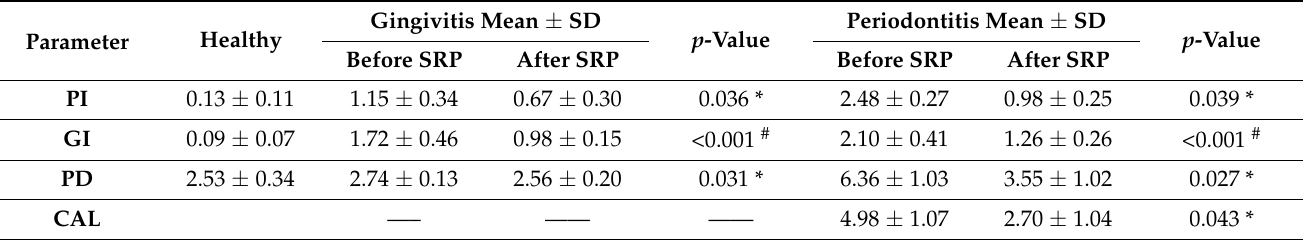
Table 1. Comparison of parameters for healthy with gingivitis and periodontitis patients before and after treatment.